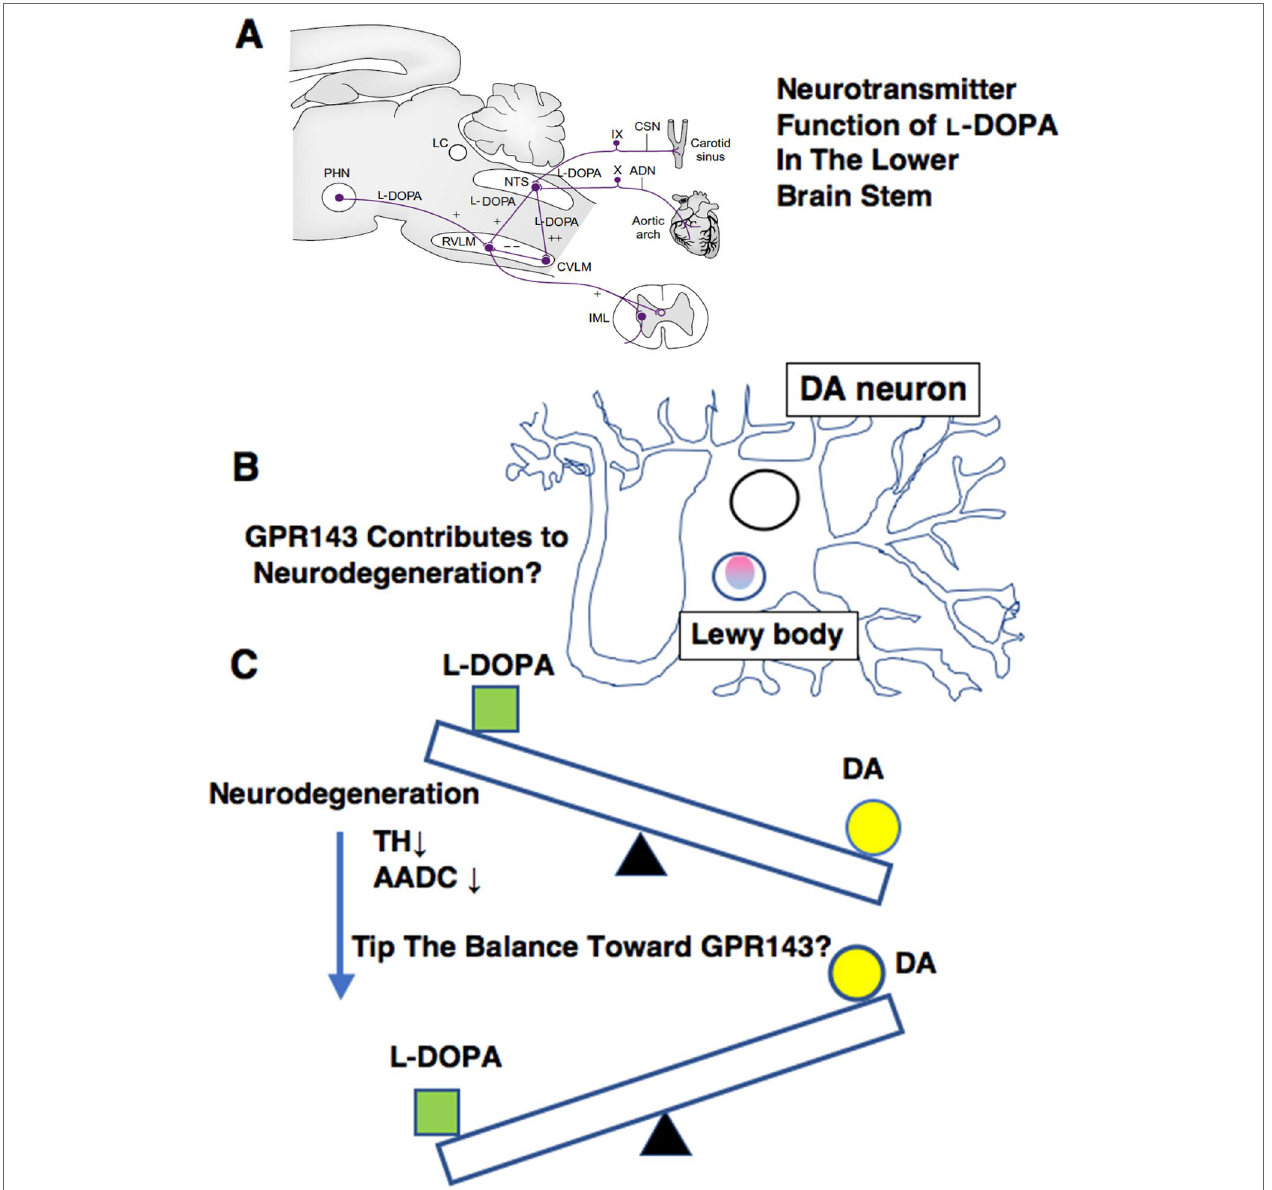
FIGURE 3 | Summary of various ways in which l - DOPA may act for normal physiology (A) , for PD pathology (B) , and for PD treatment (C) . (A) l - DOPA may play a role in carrying baroreceptor information as a neurotransmitter of the primary baroreceptor afferents terminating in the NTS. ADN, aortic depressor nerve; CSN, carotid sinus nerve; CVLM, caudal ventrolateral medulla; IML, intermediolateral cell column; LC, locus caeruleus; NTS, nucleus tractus solitarii; PHN, posterior hypothalamic nucleus; RVLM, rostral ventrolateral medulla. (See details in Misu et al., 2002) (B) GPR143 might be related to PD pathogenesis. (C) A possible impact on l - DOPA therapy. The decrease in the AADC activity may affect l -DOPA/DA receptor signaling balance in PD